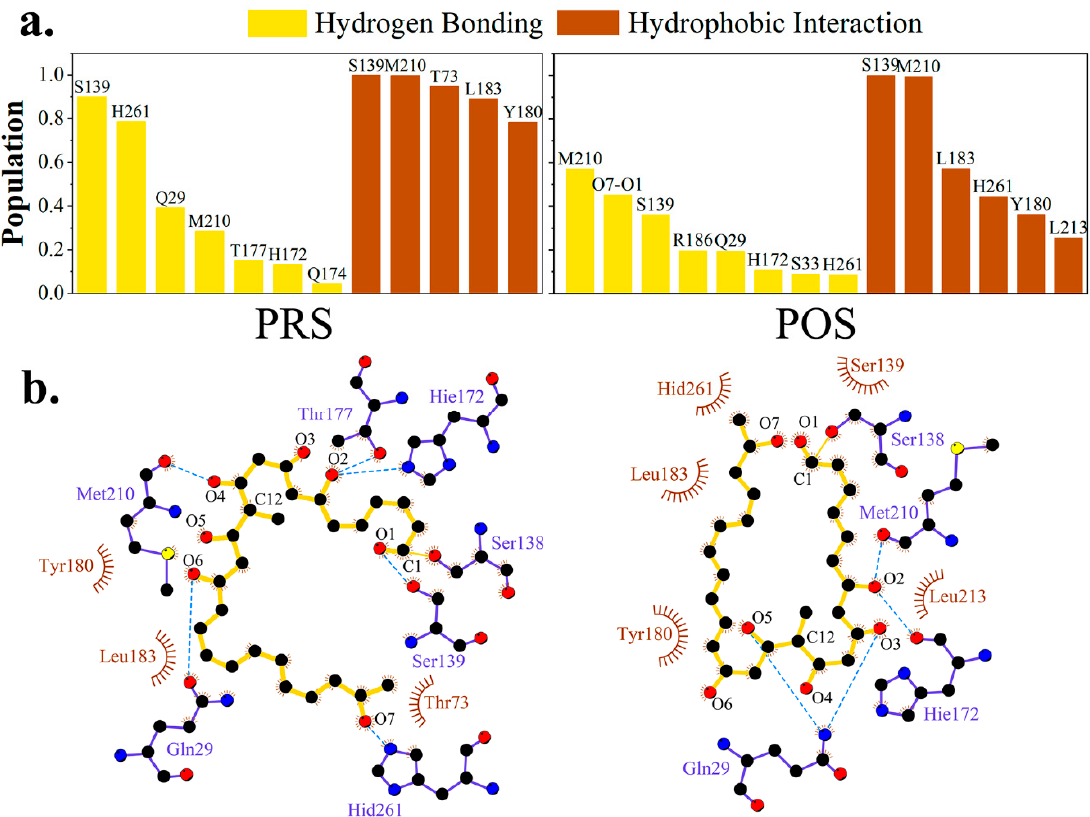
Figure 5. Hydrogen-bonding and hydrophobic interaction network variations in PRS and POS. ( a ) Proportion of top-ranked hydrogen bonding interactions. ( b ) Diagram of protein-substrate interaction produced by ligplot + [28]. Backbone of the polyketide substrate was colored in yellow, and residues providing hydrogen bonding and hydrophobic interactions in slate_blue and brown.